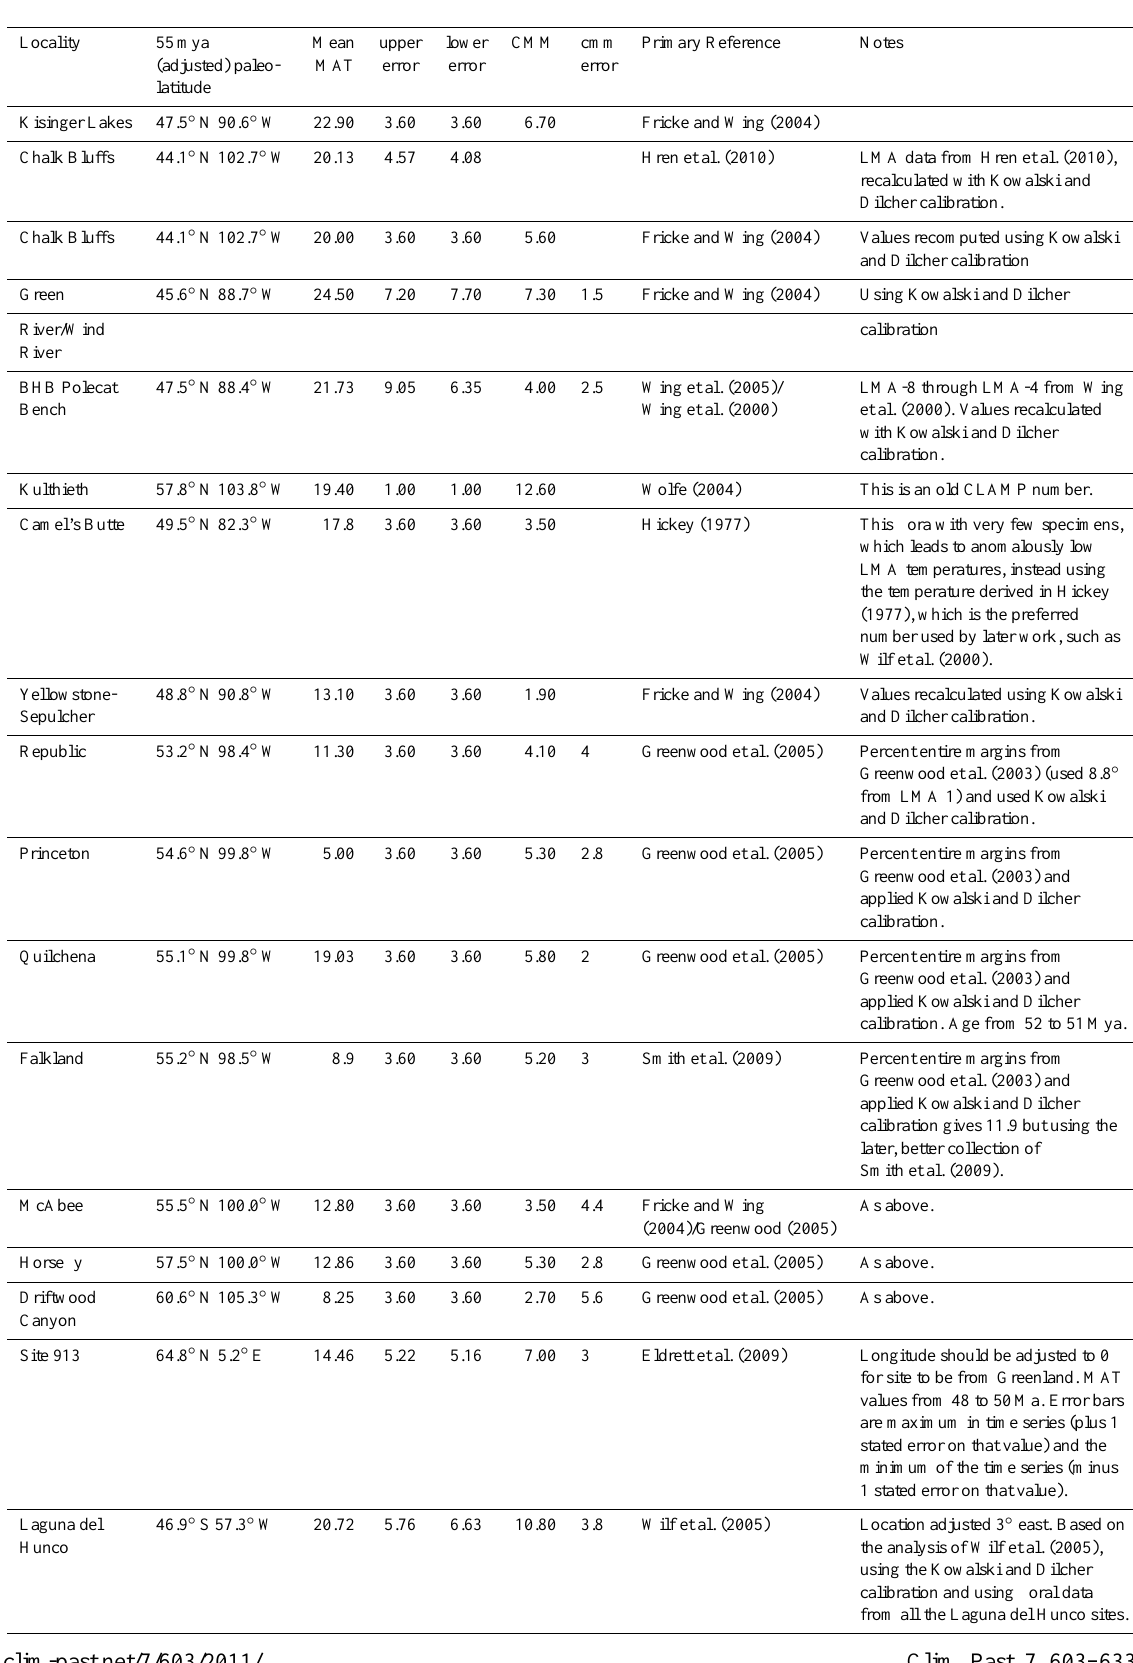
Table 1. Description of Proxy Data Sources and Treatment. Locality 55mya Mean upper lower CMM cmm Primary Reference Notes (adjusted) paleo- MAT error error error latitude Kisinger Lakes 47.5 ◦ N 90.6 ◦